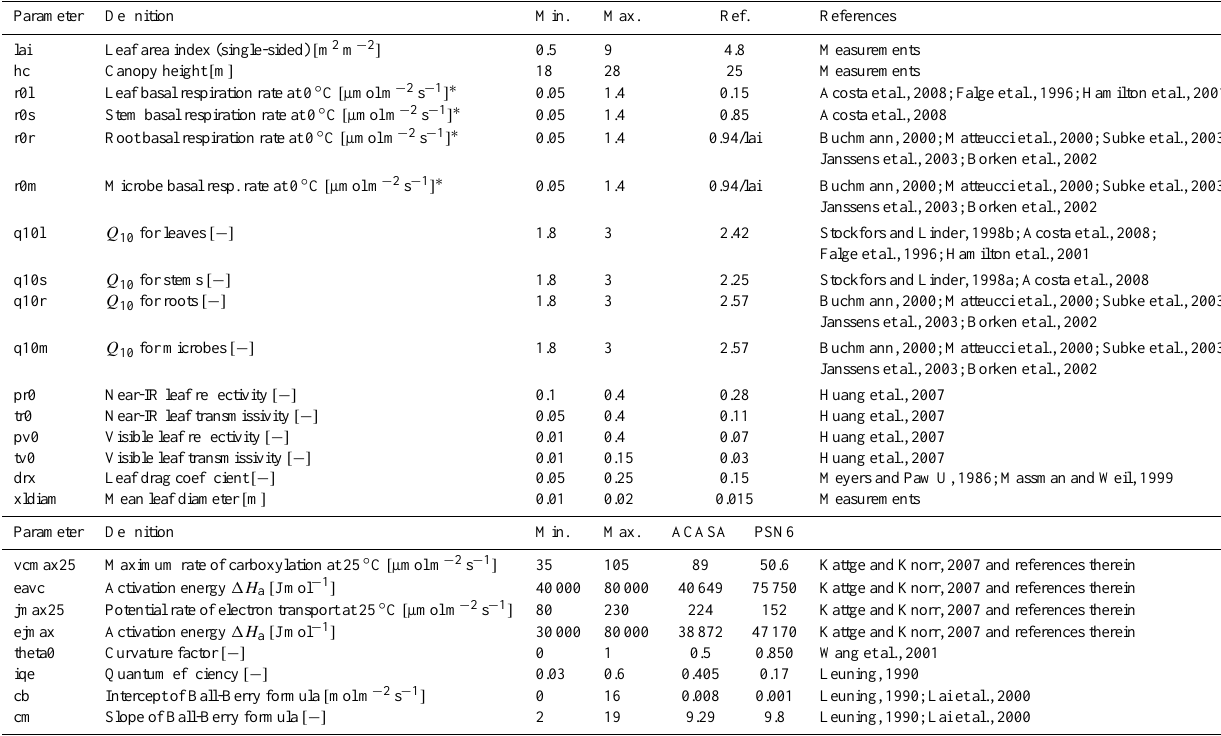
Table 2. List of the external (first 16) and internal (plant physiological, second 8) input parameters to the ACASA model which were studied in the sensitivity analysis, the range over which each parameter was varied and the reference values for the ACASA as well as the PSN6 model for our